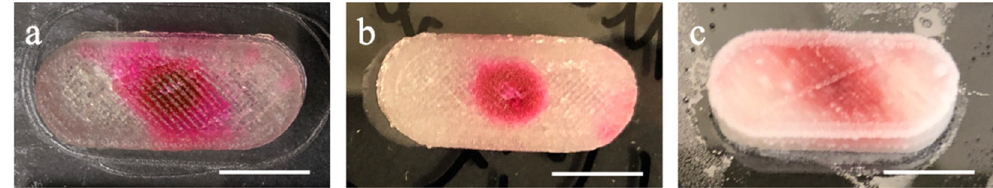
Figure 4. Capsule printed using: ( a ) 8%; ( b ) 10%; and ( c ) 12% CMC hydrogels (non-lyophilized, scale bar in 1 cm).